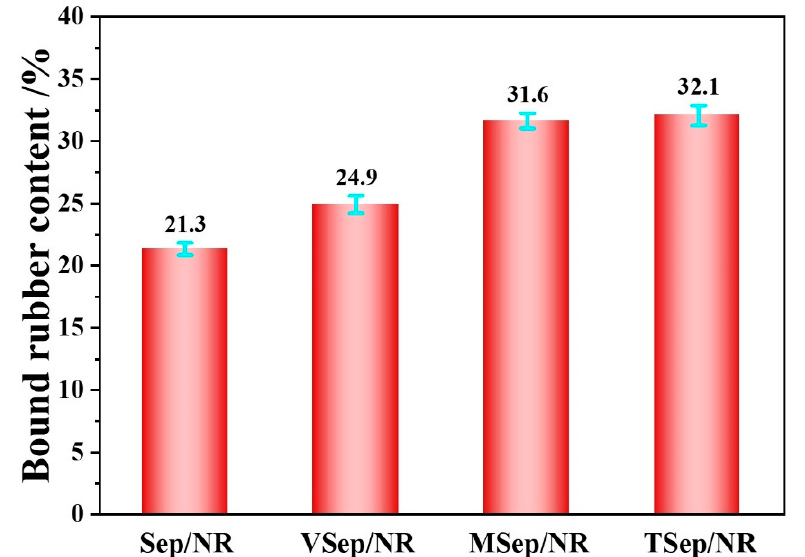
Figure 6. The bound rubber contents of sepiolite/NR composites. The interfacial interaction between rubber and sepiolite can also be characterized by the mobility of rubber chain segments at and near the sepiolite particle surface. DSC was used to analyze the ∆ C p of sepiolite/NR composites, as shown in Figure 7A, and the normalized specific heat capacity step ( ∆ C pn ) and mass fraction of the immobilized polymer layer ( χ im ) of sepiolite/NR composites are illustrated in Figure 7B. The values of ∆ C p for NR/sepiolite composites were all lower than the Neat NR (the natural rubber contains zinc oxide, stearic acid, CZ, DM, and sulfur in the same amount as in Table 2, but without other reinforcing materials such as sepiolite), indicating restricted movement of molecular chains and chain segments due to the addition of sepiolite. Comparing the samples with silane coupling agents to Sep/NR samples, the ∆ C p and ∆ C pn values of the modified blends were significantly lower, and the mass fraction of the immobilized polymer layer ( χ im ) was significantly increased. This indicated tighter bonding between natural rubber and sepiolite and improved interfacial strength. Comparing VSep/NR, MSep/NR, and TSep/NR, it was observed that the χ im value of TSep/NR was the largest, followed by MSep/NR and VSep/NR, suggesting that there is a difference in the bonding ability between sepiolite and the rubber matrix after modification with different coupling agents. TESPT-modified sepiolite had the strongest bonding ability between sepiolite and the natural rubber matrix, and the interfacial strength was the largest, which was consistent with the change in the bound rubber content to the